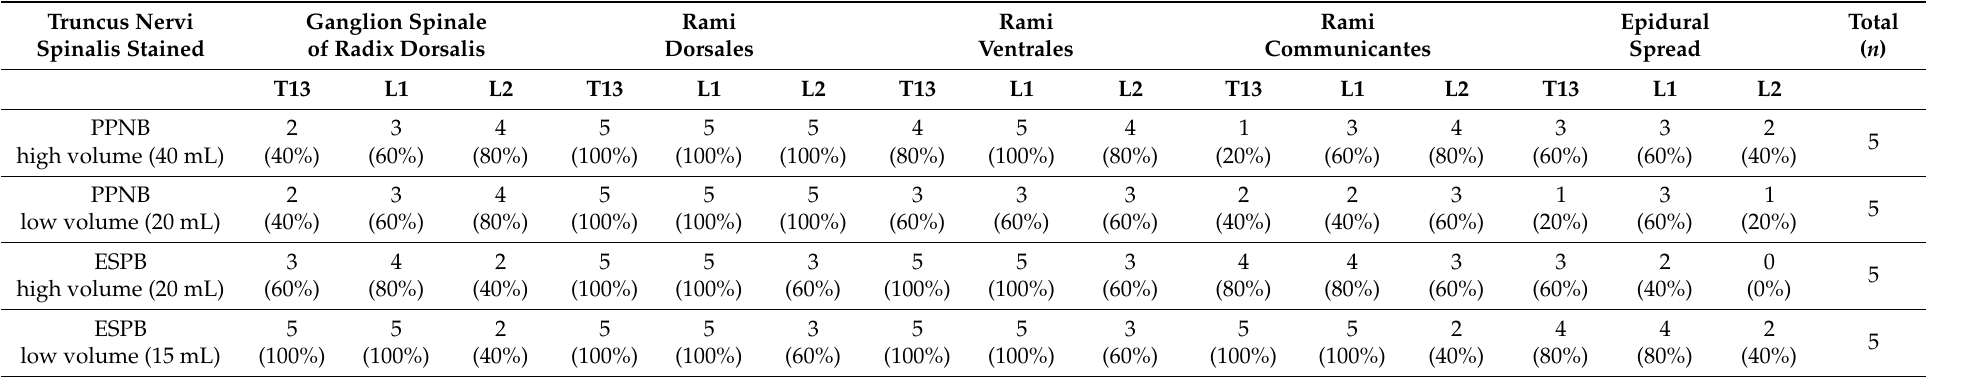
Table 1. Structures of the spinal nerves stained in the different groups (blind proximal paravertebral nerve block (PPNB) high volume (40 mL), PPNB low volume (20 mL), ultrasound guided erector spinae plane block (ESPB) high volume (20 mL) and ESPB low volume (15 mL). Staining was considered positive when at least 2 cm were stained with methylene blue solution.